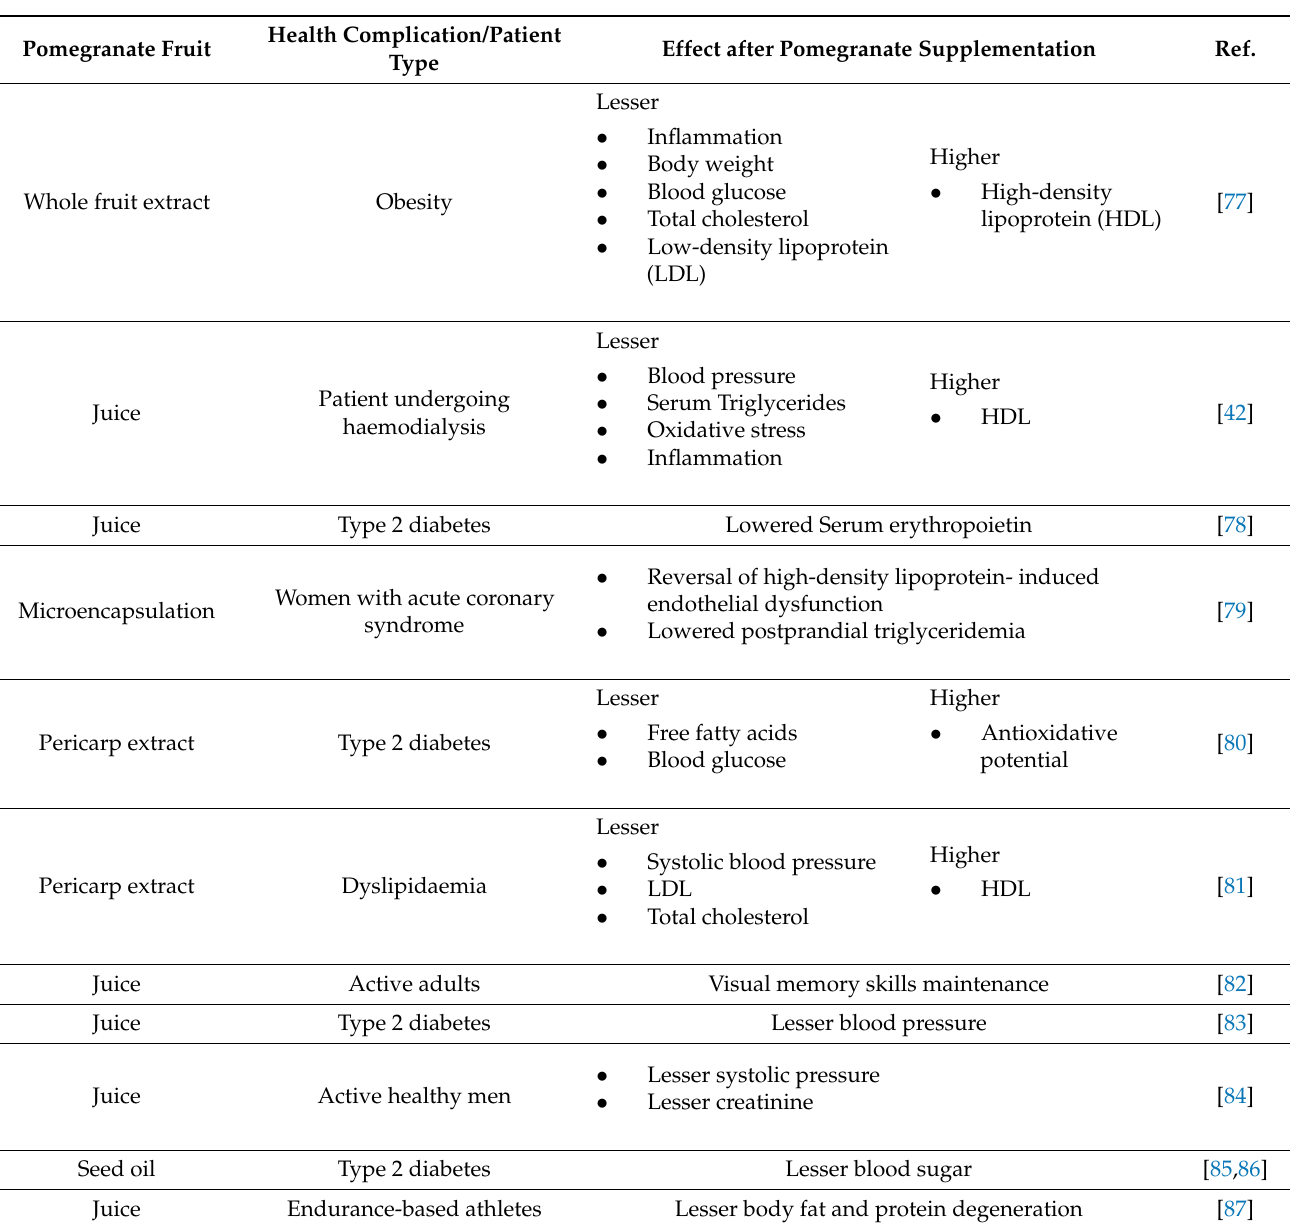
Table 3. Effects of pomegranate fruits and its extracts on human